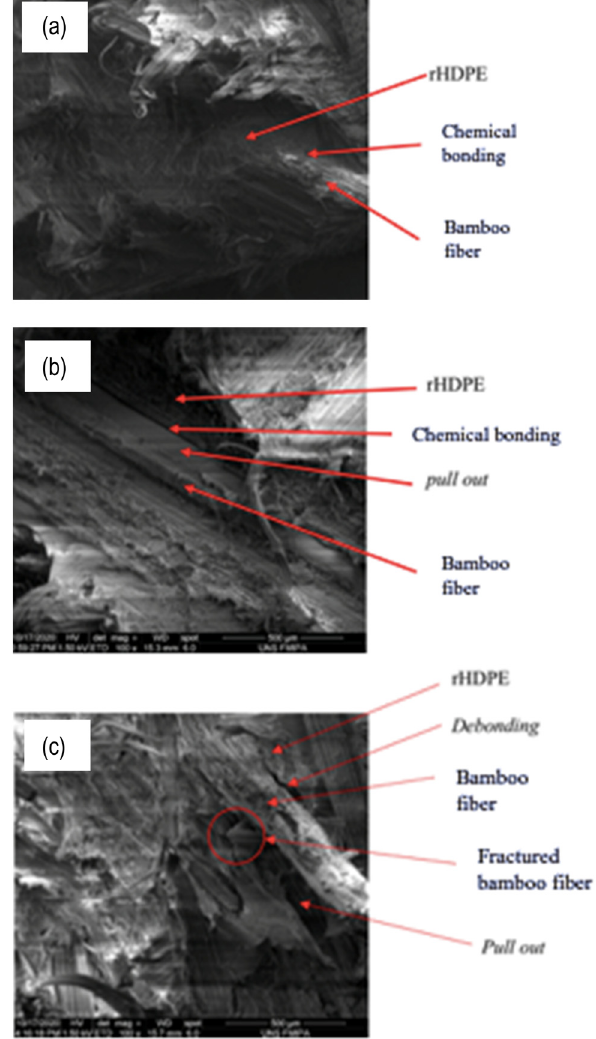
Figure 5: SEM image of the specimens: ( a ) r - HDPE - bamboo 10%; ( b ) r - HDPE - bamboo 20% dan; ( c ) r - HDPE - bamboo